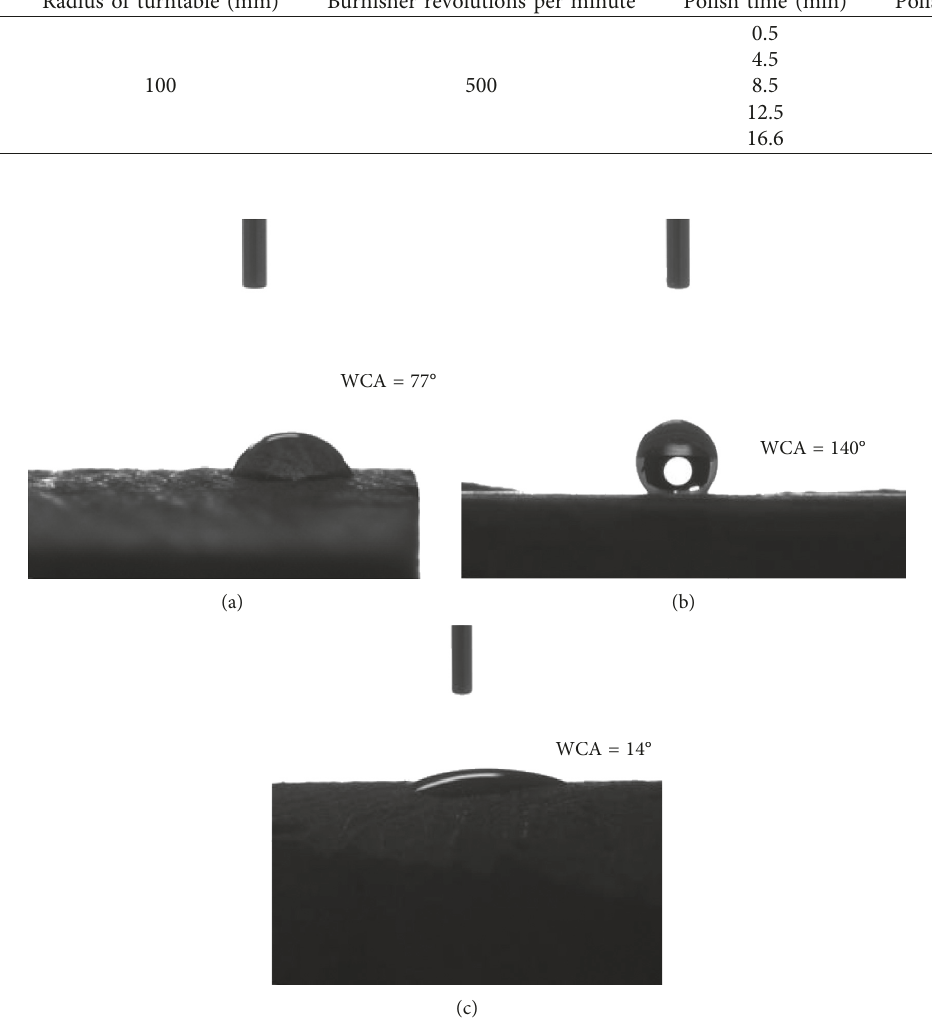
Figure 5: WCA of the (a) baseline sample, (b) hydrophobic sample, and (c) polished hydrophobic